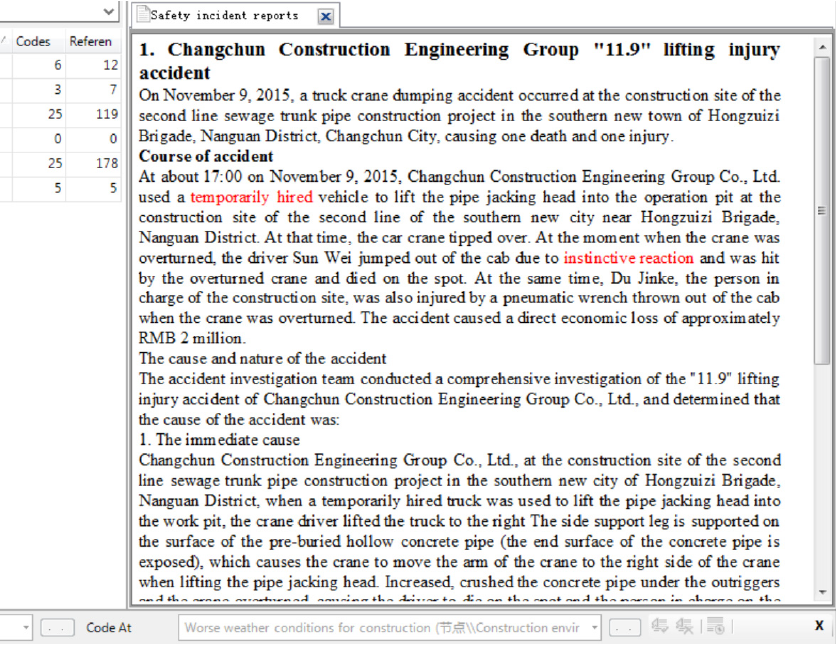
Figure 2. A part of a safety accident report and its analysis process.